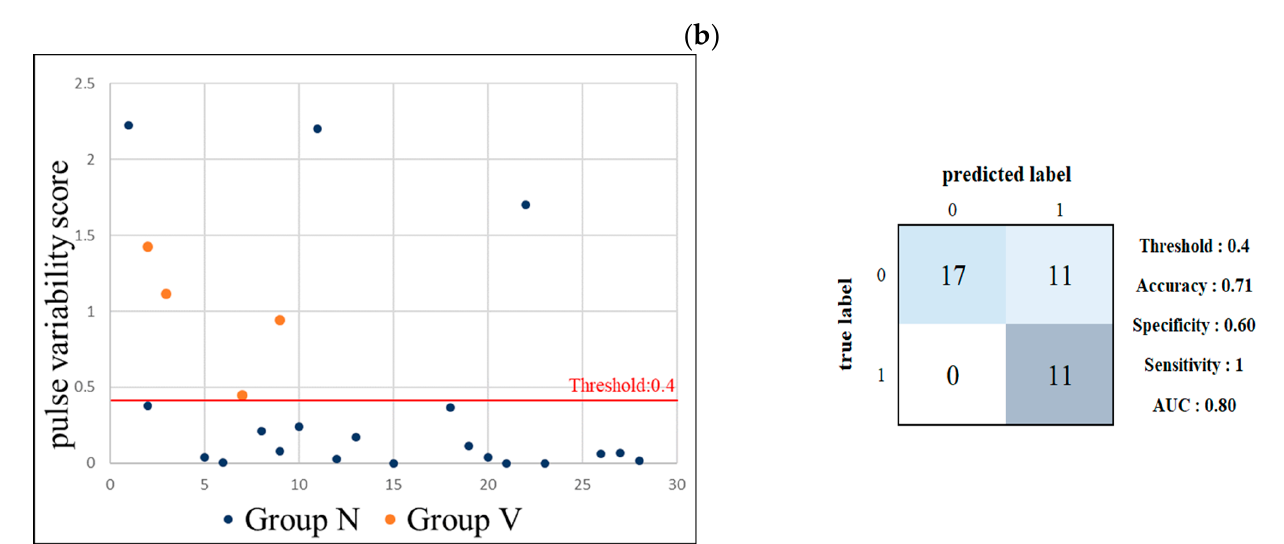
Figure 8. Results of pulse-variability score analysis of BPW indices for discrimination between Groups N (0; n = 28) and V (1; n = 11). ( a ) Threshold = 17.1 produced accuracy = 82.05%, specificity = 0.92, sensitivity = 0.54, and AUC = 0.73. This analysis achieved a very high specificity and an acceptable discrimination level. The AUC value was higher than that between Groups N and CV (Figure 6). ( b ) Threshold = 0.4 produced accuracy = 71.79%, specificity = 0.60, sensitivity = 1, and AUC = 0.80. The AUC of 0.80 indicates an excellent discrimination level. All of the subjects with vascular side effects were accurately identified (sensitivity = 1.00).